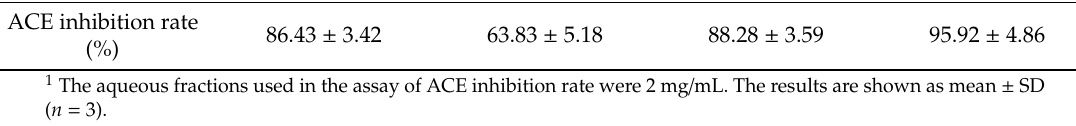
Table 5. Angiotensin-converting enzyme (ACE)-inhibitory activity of RF1-RF4 1 .